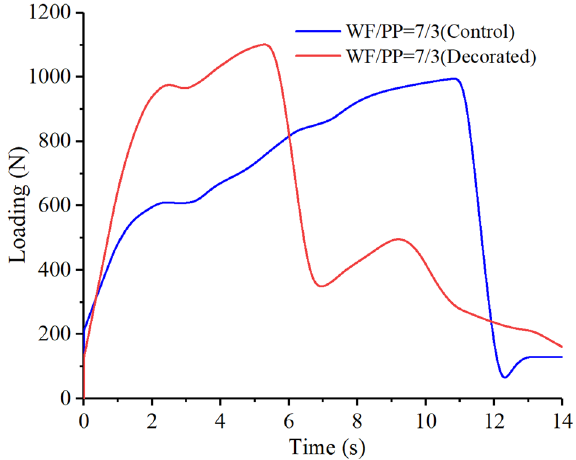
Figure 16. The low-velocity impact loading-time curve of the WF/PP = 7/3 specimens.